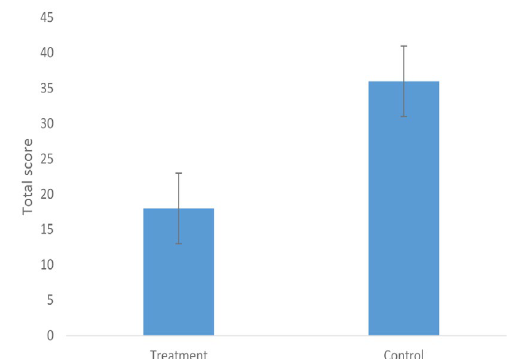
Fig. 4. Degradation of Cur-PCL nanofibers in SEM images A) after 1 week B) after 2 weeks C) after 3 weeks D) after 4 weeks.